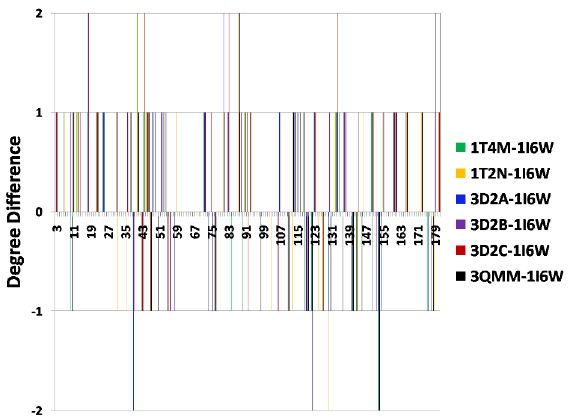
Figure 2. Residue-wise difference between the degree values of the mutants and WT.